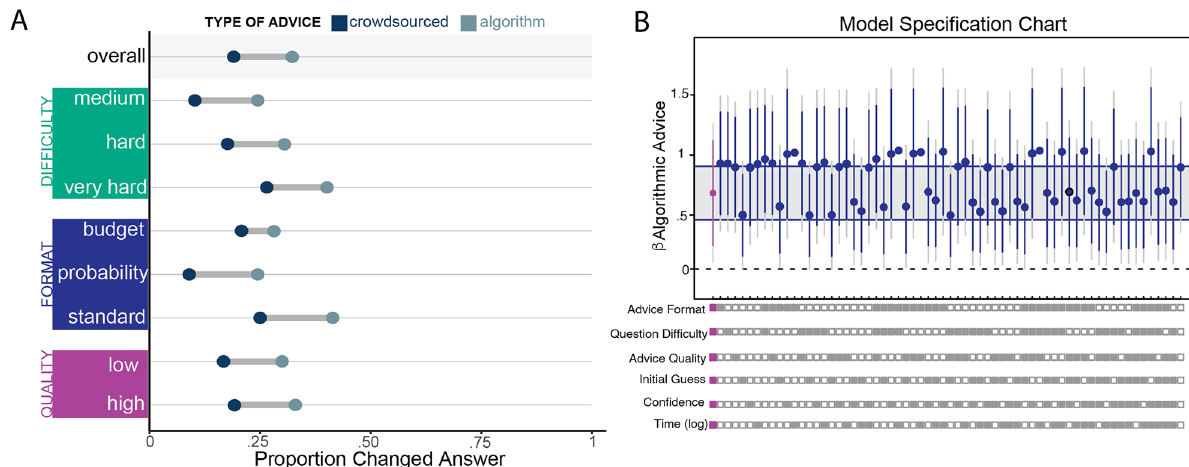
Figure 2. Effect of advice source on acceptance of advice. ( A ) Percentage of observations where individuals changed their answer after being provided with advice. The overall rate encompasses all 2772 observations. Each subsequent comparison filters the data by advice format, question difficulty, or advice quality. All differences are statistically significant using Tukey multiple comparison tests at the 95% confidence level. ( B ) Specification chart illustrating estimates of the coefficient for the effect of algorithmic advice on whether participants changed answers. Each model has a varying number of control variables. The boxes below the chart indicate which controls are included (filled box) or excluded (empty box). The main result is highlighted in purple and contains all controls. All estimates are produced by mixed effects logistic regression models with random slopes for the participants. Intervals are 95% and 99% confidence intervals for the estimates; the grey band is one standard deviation above and below the main